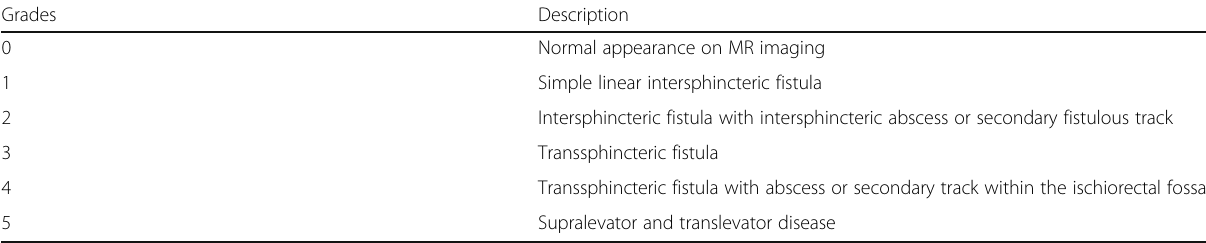
Table 1 St. James ’ s University Hospital MR imaging classification of fistula in ano [30]